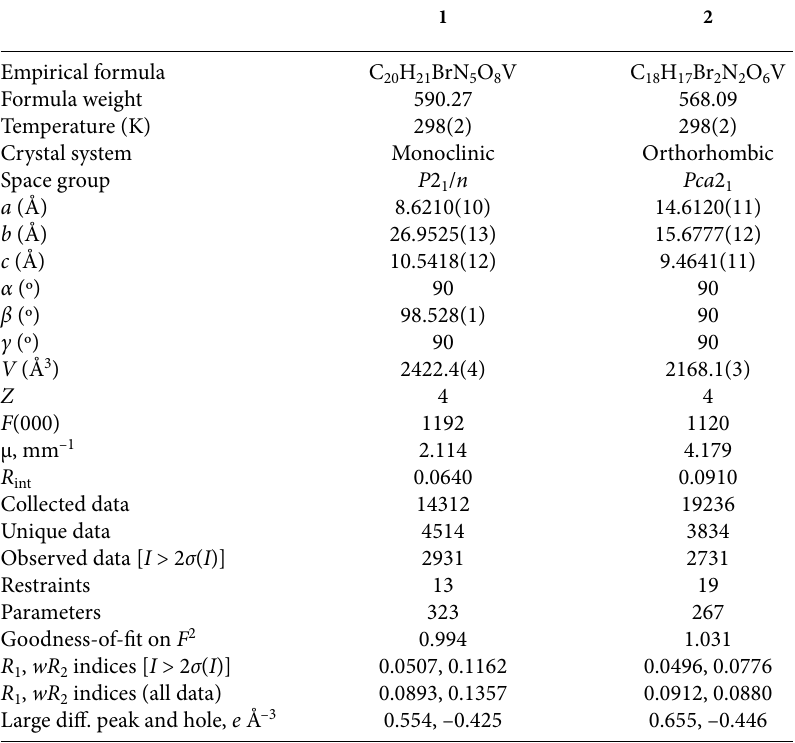
Table 1. Crystallographic data for the single crystal of the